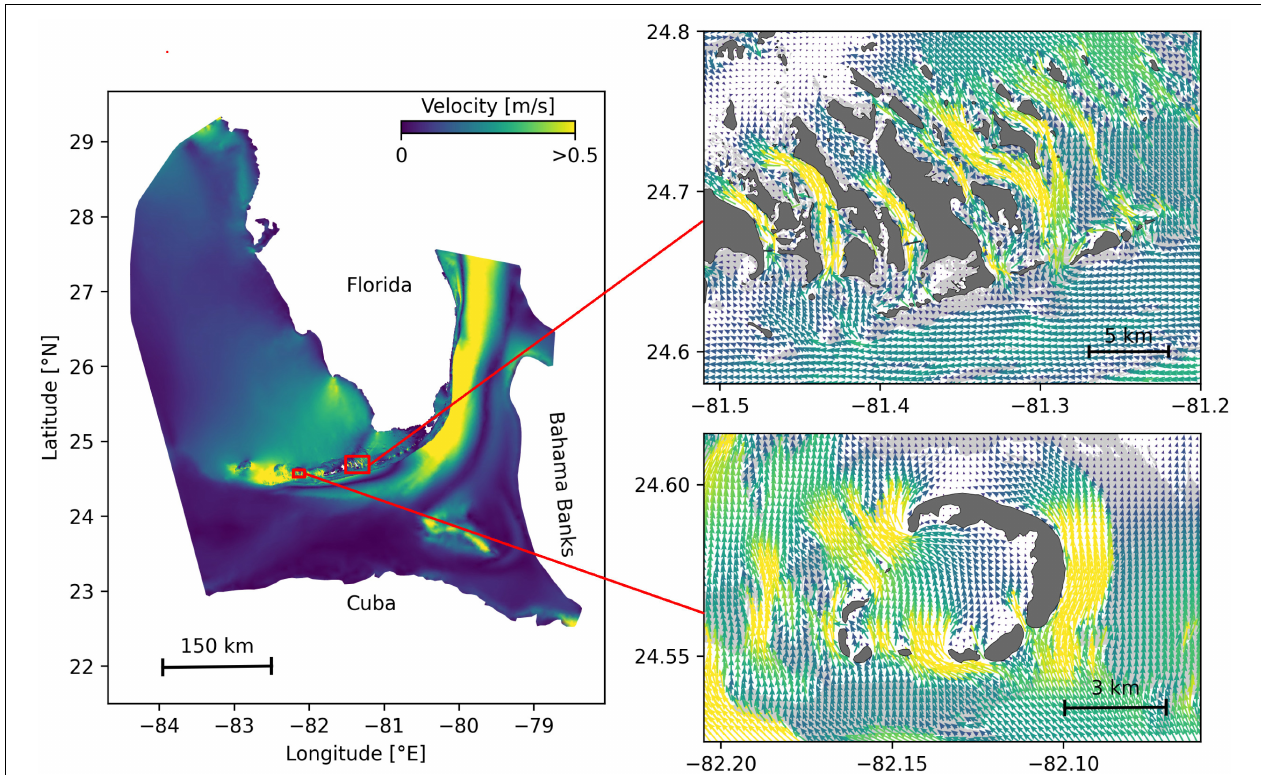
FIGURE 1 | Model computational domain and close-up views of the mesh with snapshots of the currents on May 25, 2018 at 00:00, for the Marquesas Keys (bottom) and the Lower Keys (top) . This illustrates the benefits of unstructured meshes to represent the fine-scale details of the topography and hence simulate currents down to the scale of individual reefs (shown in light gray) and islands (shown in darker